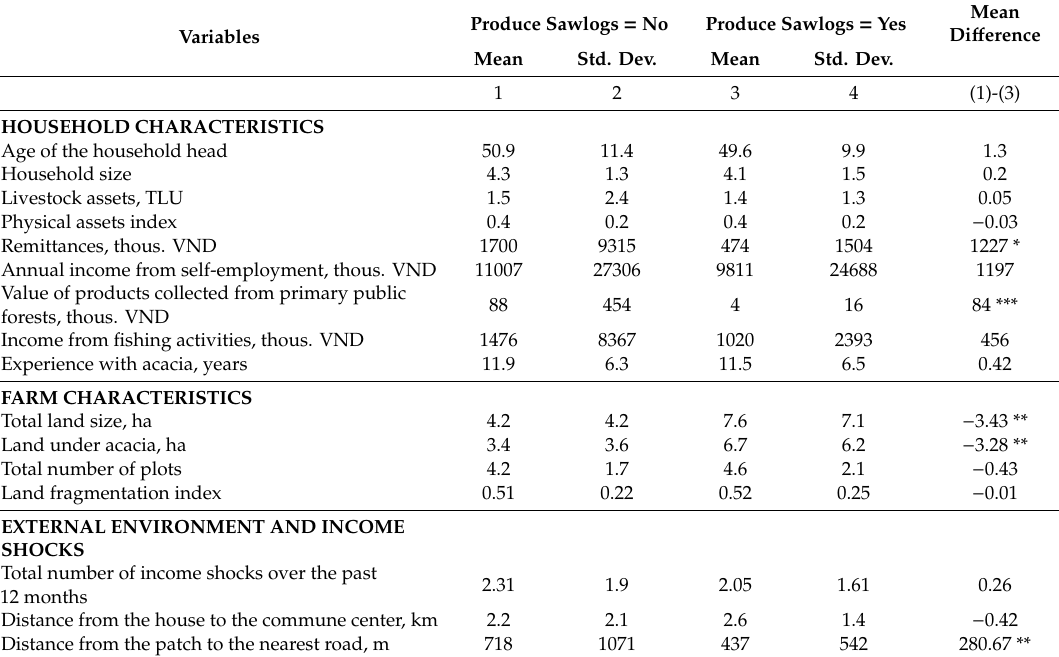
Table 4. Di ff erences between forest owners who produce and who do not produce sawlogs: continuous variables.